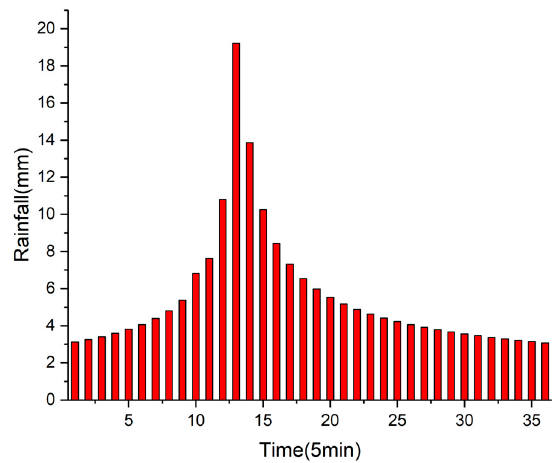
Figure 3. Chicago rainfall pattern.